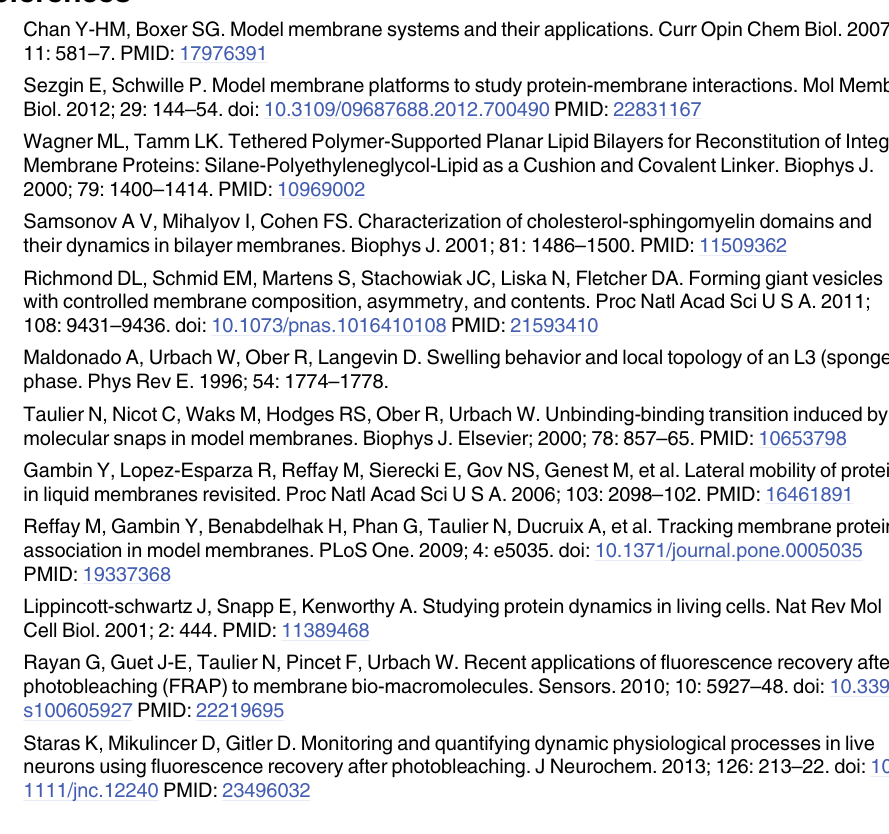
(cid:2) R > all differ by less than 20%